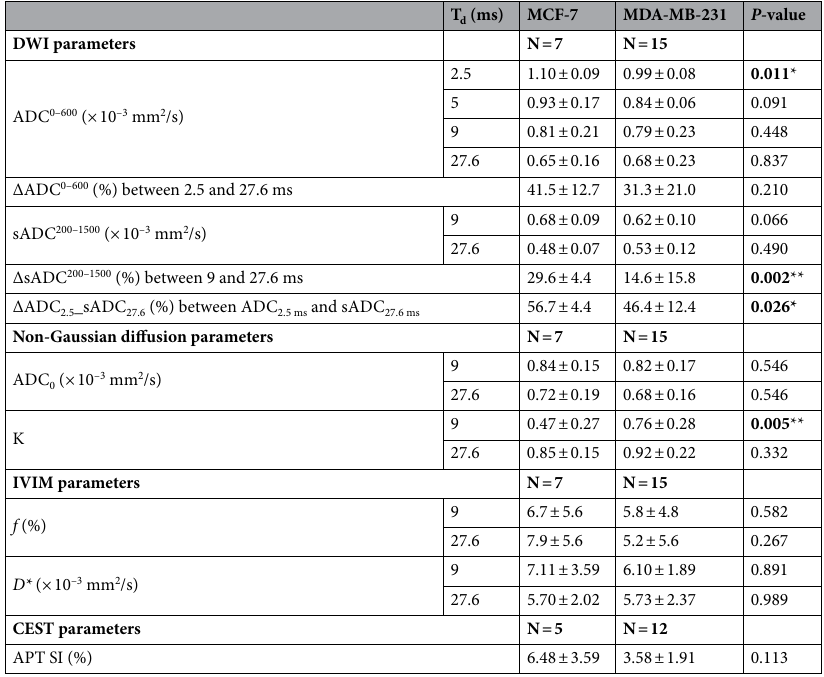
Table 1. MRI parameters for the MCF-7 and MDA-MB-231 groups. P < 0.05*, P < 0.01**, considered as statistically significant.